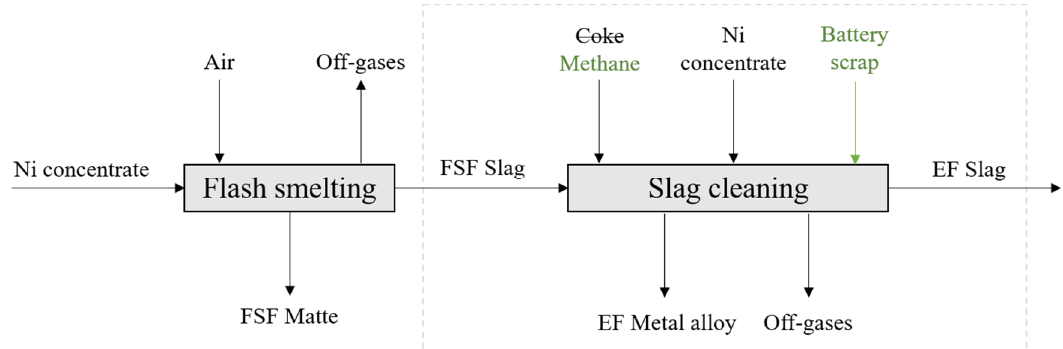
Figure 1. A simplified flowchart of nickel flash smelting (DON) and slag cleaning. The box drawn with dashed lines indicates the focus area of this study. In this work, coke was replaced with methane and battery scrap was added as part of the feed material mixture.